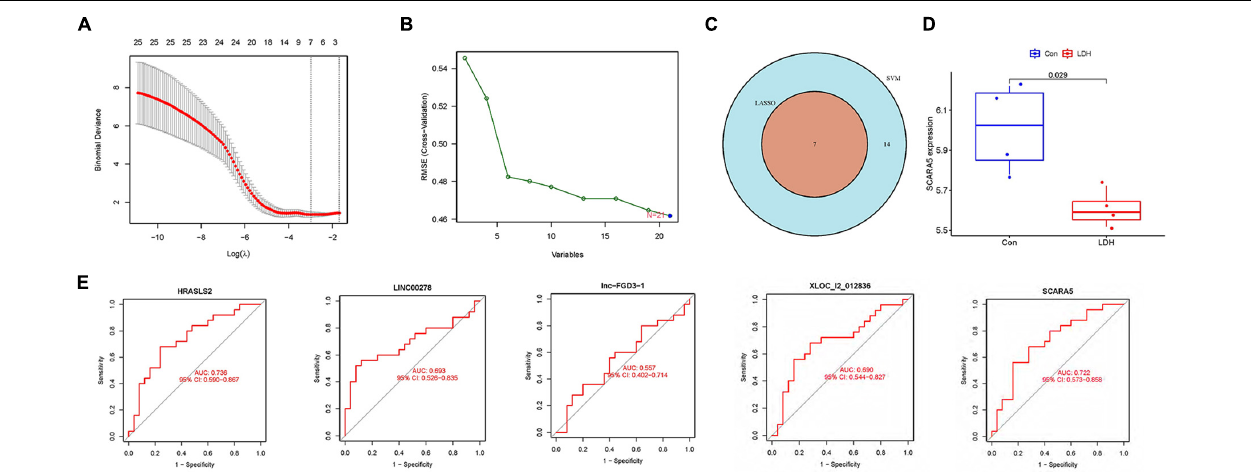
FIGURE 4 | Identification of diagnostic biomarkers in LDH. (A) The gene numbers screened by the LASSO. (B) The gene numbers screened by the support vector machine recursive feature elimination (SVM-RFE). (C) The Venn plot was adopted to show the intersection genes between LASSO and SVM-RFE. (D) The distribution of scavenger receptor class A member 5 (SCARA5) between healthy and LDH group in GSE42611 dataset. (E) Receiver operating characteristic (ROC) curves showed the prediction efficiency of diagnostic